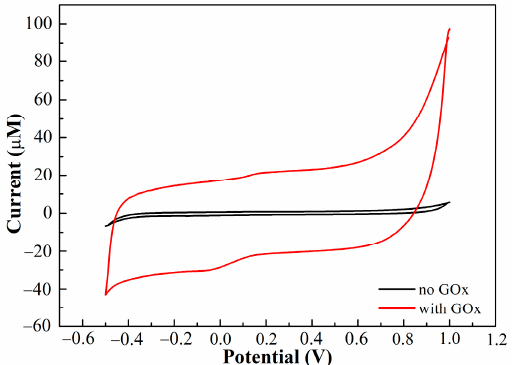
Figure 5. CV response of the SPCE/PEDOT:PSS/Ti 3 C 2 /GQD in the presence and absence of glucose oxidase with 500 µM of glucose in ammonium acetate solution at scan rate of 0.01 V/s.